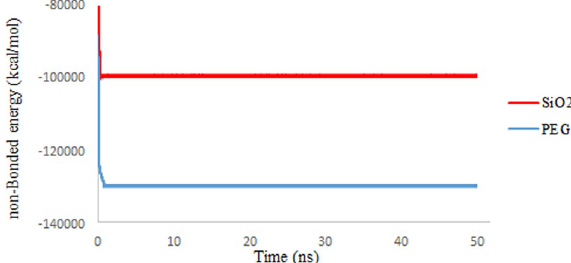
Figure 11. Non-bond interaction energies between 3TC and SiO 2 (red), PEG (blue).